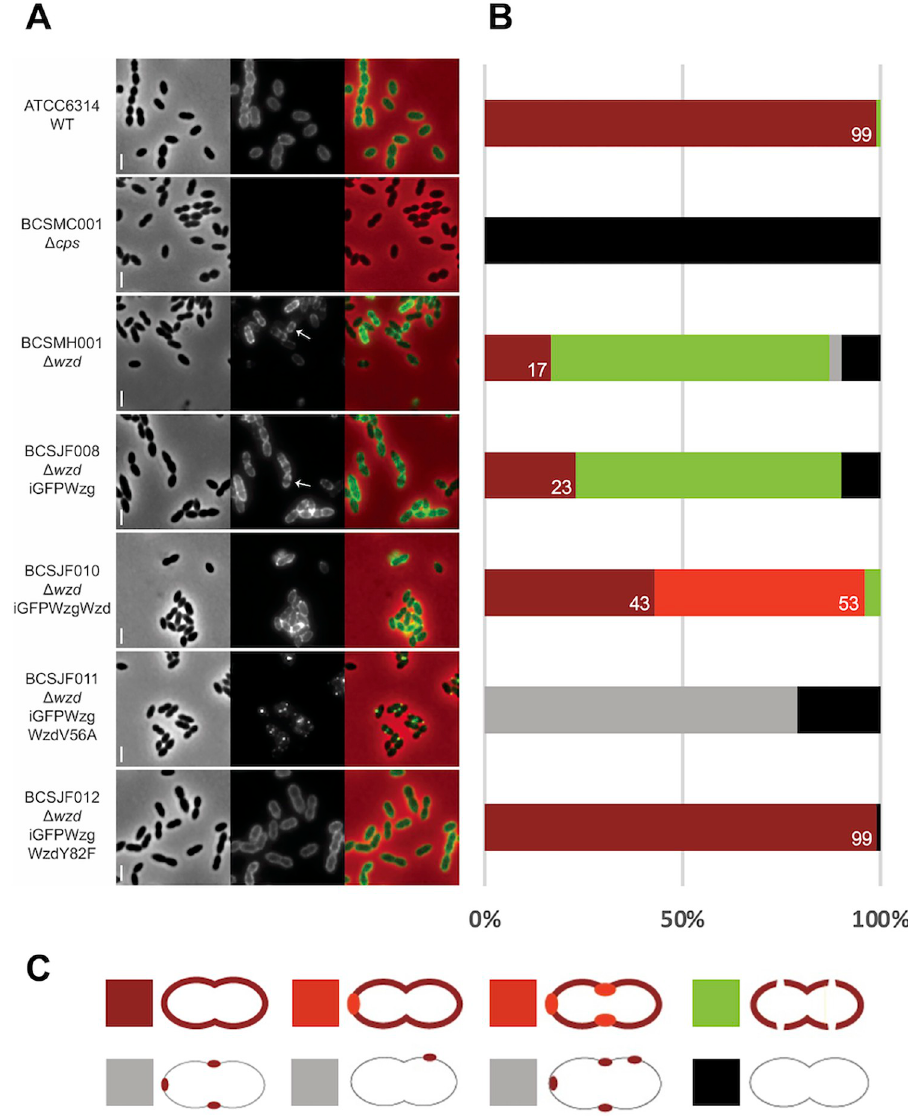
Fig 6. Expression of WzdV56A impairs the Wzg ability to produce a pneumococcal cell surface fully surrounded by capsule. A) Immunofluorescence microscopy images using a serotype-14 specific serum to detect the presence of the capsular polysaccharide at the cell surface. Wild-type encapsulated ATCC6314 (n = 115) expressed capsule all over the surface, while wzd null mutant strain BCSMH001 lacked capsule at midcell (n = 115). Cells of wzd null mutant strain were transformed with plasmids expressing (i) iGFP-Wzg alone (BCSJF008, n = 108), resulting in cells where the capsule is absent from the division septum; (ii) iGFP-Wzg and Wzd (BCSJF010, n = 104), or with WzdY82F (BCSJF012, n = 117), resulting in cells with homogeneous distribution of CPS at their surface or (iii) iGFP-Wzg and WzdV56A (strain BCSJF011, n = 105), resulting in cells where CPS accumulated in spots and was absent from most of the bacterial cell surface. Representative phase contrast (top panels, for visualization of bacteria), fluorescence microscopy (middle panels, for detection of the capsule associated with the bacterial cell surface) and overlay (bottom panels) images of each strain are shown. Arrows highlight bacteria that lack CPS at midcell. Scale bar, 2 μ m. B) Graph shows the percentage of cells, for each strain, with different CPS patterns (grouped in 5 different classes). Numbers represent the percentage of cells fully covered with CPS. C) Classes of CPS patterns: cells fully covered with homogenous CPS (dark red); cells fully covered with CPS whose staining is heterogenous and has brighter regions (light red); cells partially covered with interruptions at the division septum (green); cells with CPS only in spots in particular regions (grey) or lacking CPS (black).